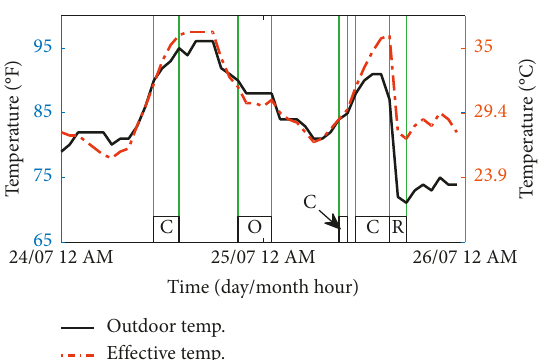
Figure 10: Relation between temperature and weather conditions: C, O, and R represent cloudy, overcast, and rain, respectively; the rest is